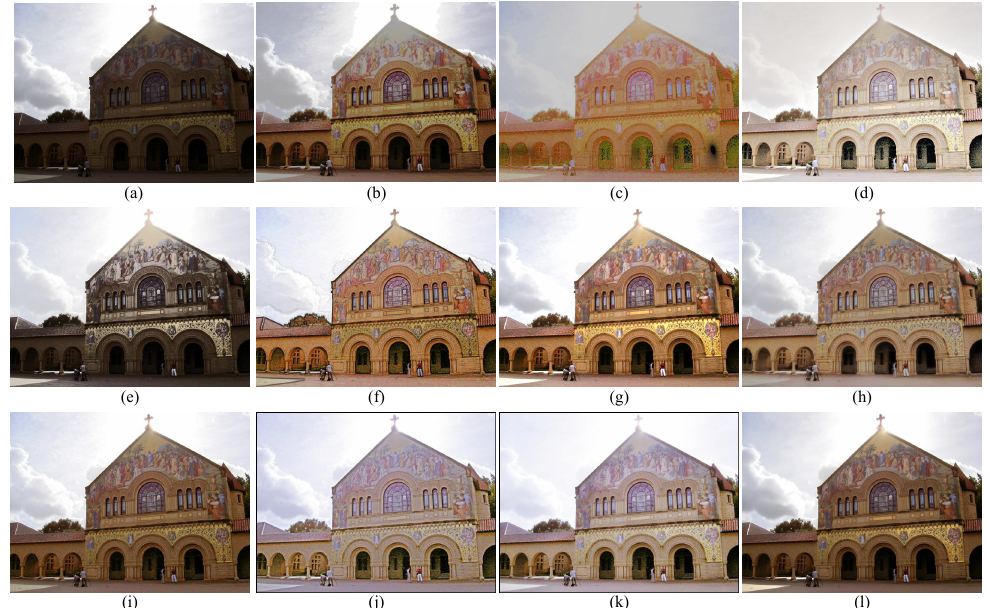
Figure 6. Visual comparison between low-light image enhancement results in the exemplar